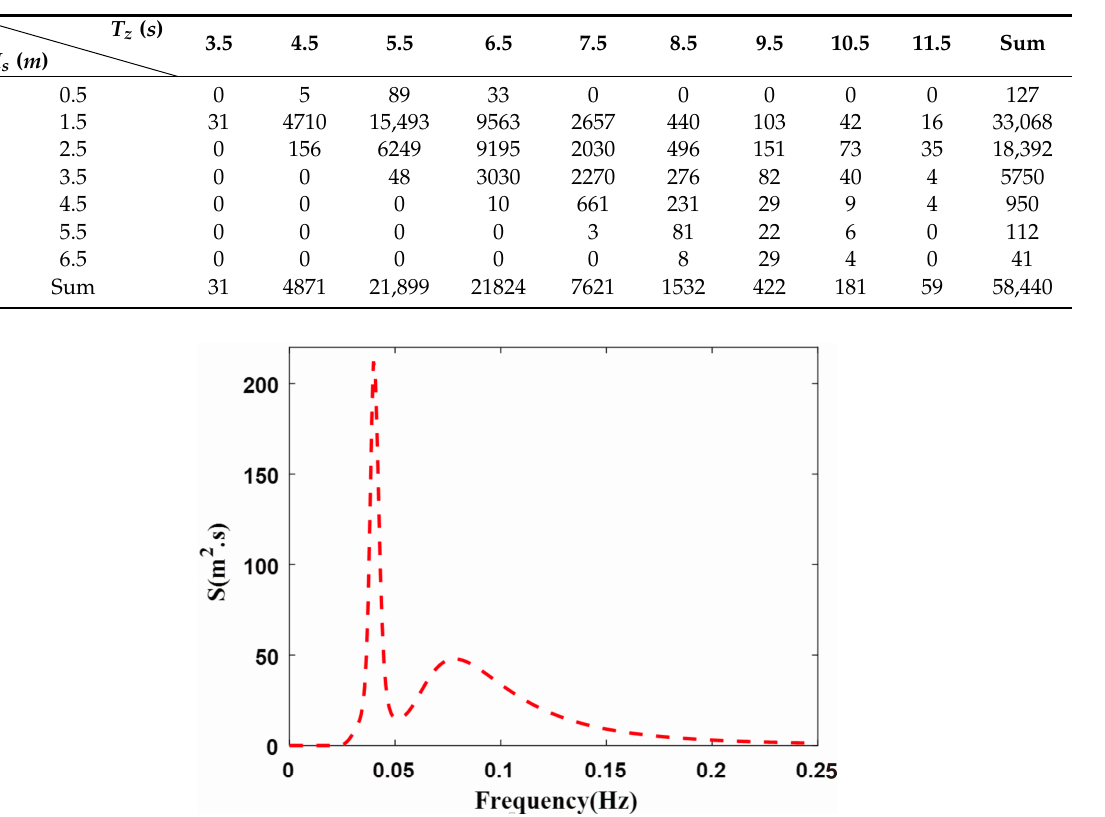
Table 6. Scatter diagram of H s and T z .